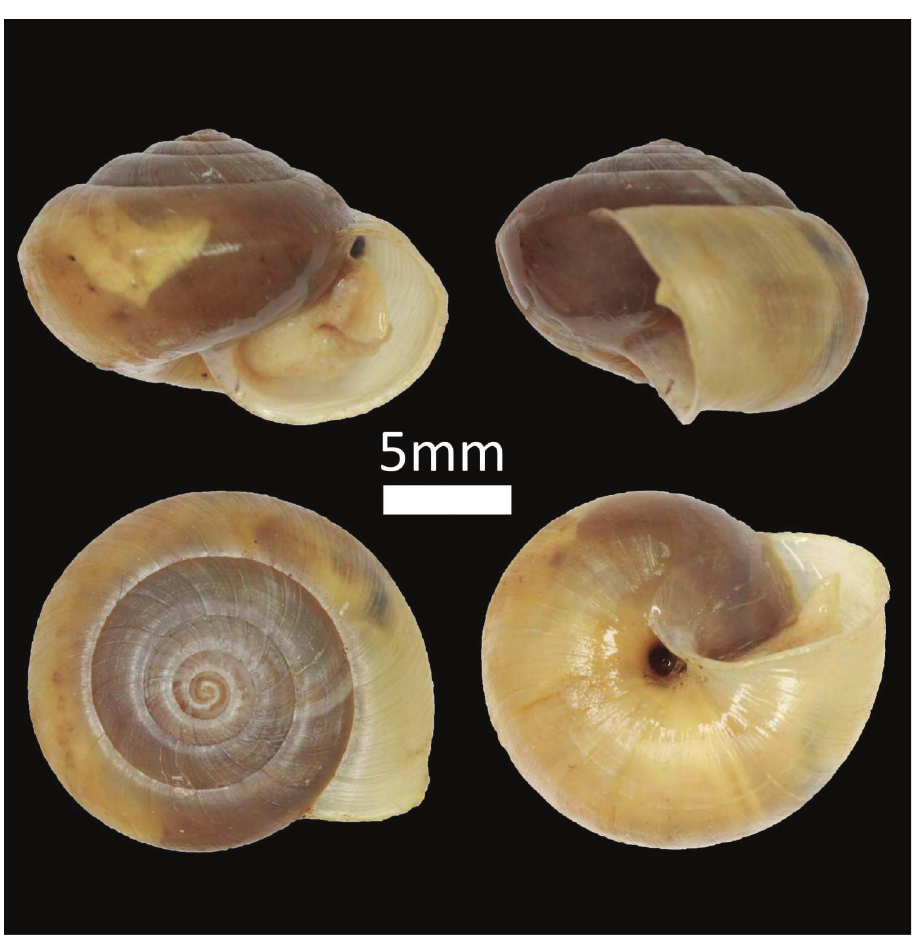
Figure 13. Family Bradybaenidae. Bradybaena similaris (BOR/MOL 6766).